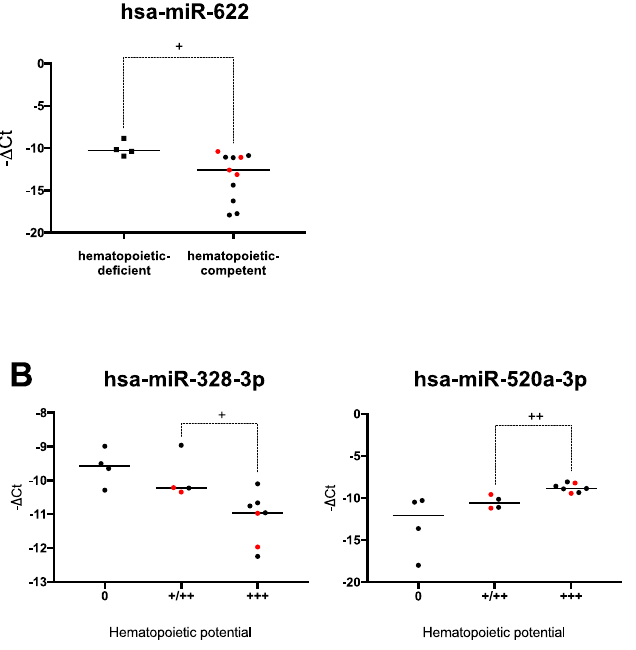
Figure 3. Differential miRNA expression according to hPSC hematopoietic capability. ( A ) The expression level of miR-105, miR-122, miR-135b, miR-206, miR-296, miR-335, miR-492, miR-515, miR-520a and miR-622 in hematopoietic-deficient and -competent hPSCs, at the pluripotent stage, is shown as vertical scatter dot plot with median; ( B ) The expression level of miR-328 and miR-520a in hematopoietic-deficient, poor and high competent hPSCs, at the pluripotent stage, is shown as vertical scatter dot plot with median. MicroRNA expression levels were estimated by a – Δ Ct calculation (with Δ Ct = Ct miRNA – Ct RNU48), from the TLDA analysis. Human ES cells are represented in red and hiPSCs in black. P-values were calculated by using the LiMMa package from Integromics (+ p < 0,05; ++ p < 0,01; +++ p < 0,001).